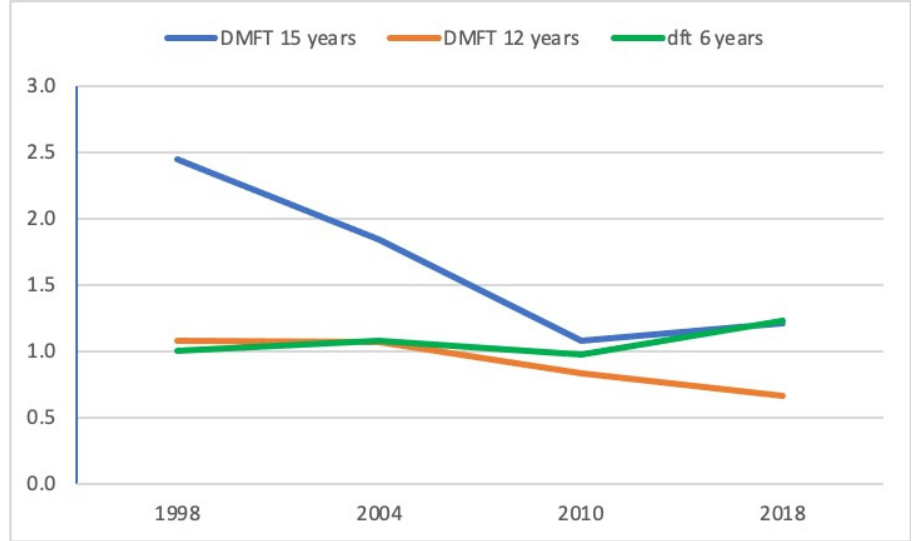
Figure 1. Evolution of caries indices between 1998 and 2018.